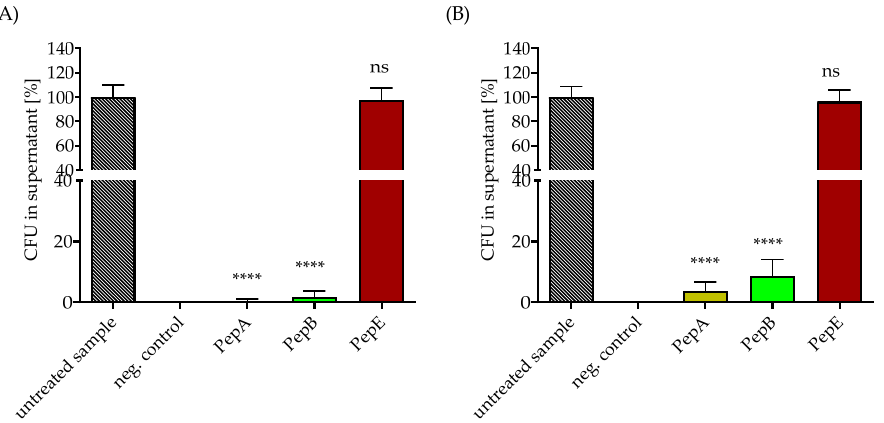
Figure 5. Removal of S. aureus (panel ( A )) or S. pneumoniae (panel ( B )) under static conditions from Ringer solution. The concentration of bacteria was set to 10 3 CFU/mL. Separations were carried out with 300 µg Fe/mL peptide-functionalized SPION-APTES. Unspiked samples served as negative control. The results shown represent the mean values with standard deviations of three independent experiments. Statistical testing was performed between untreated and treated samples using a two-way ANOVA test with a post hoc Dunn’s test; **** p < 0.0001. p values above 0.05 were considered non-significant (ns).